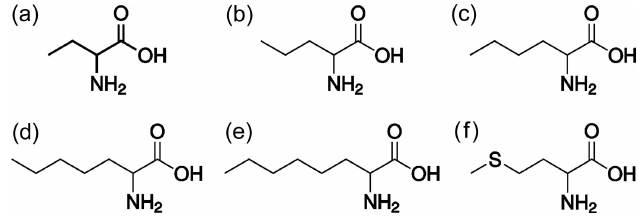
Figure 1 Molecular structures of the amino acids studied: ( a ) 2-aminobutyric acid, ( b ) norvaline, ( c ) norleucine, ( d ) 2-aminoheptanoic acid, ( e ) 2- aminooctanoic acid and ( f )